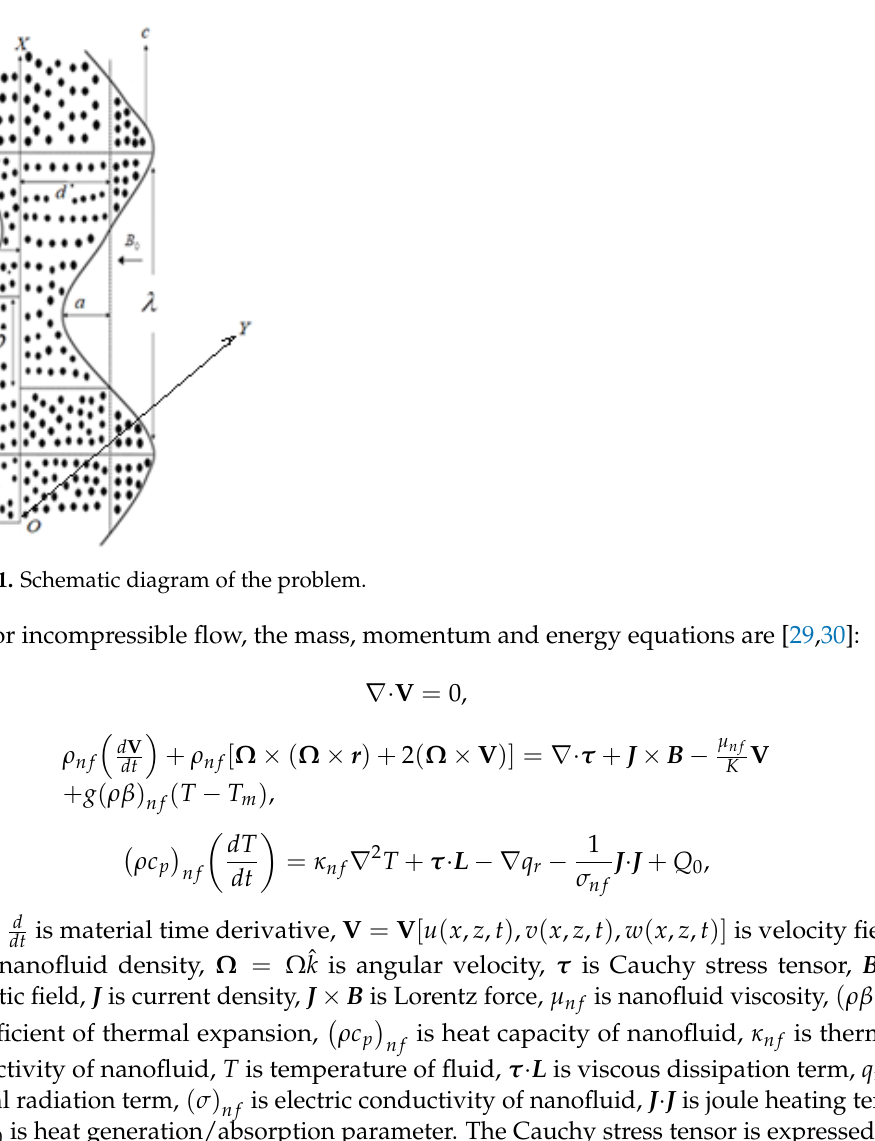
Physically the problem is presented in Figure 1.